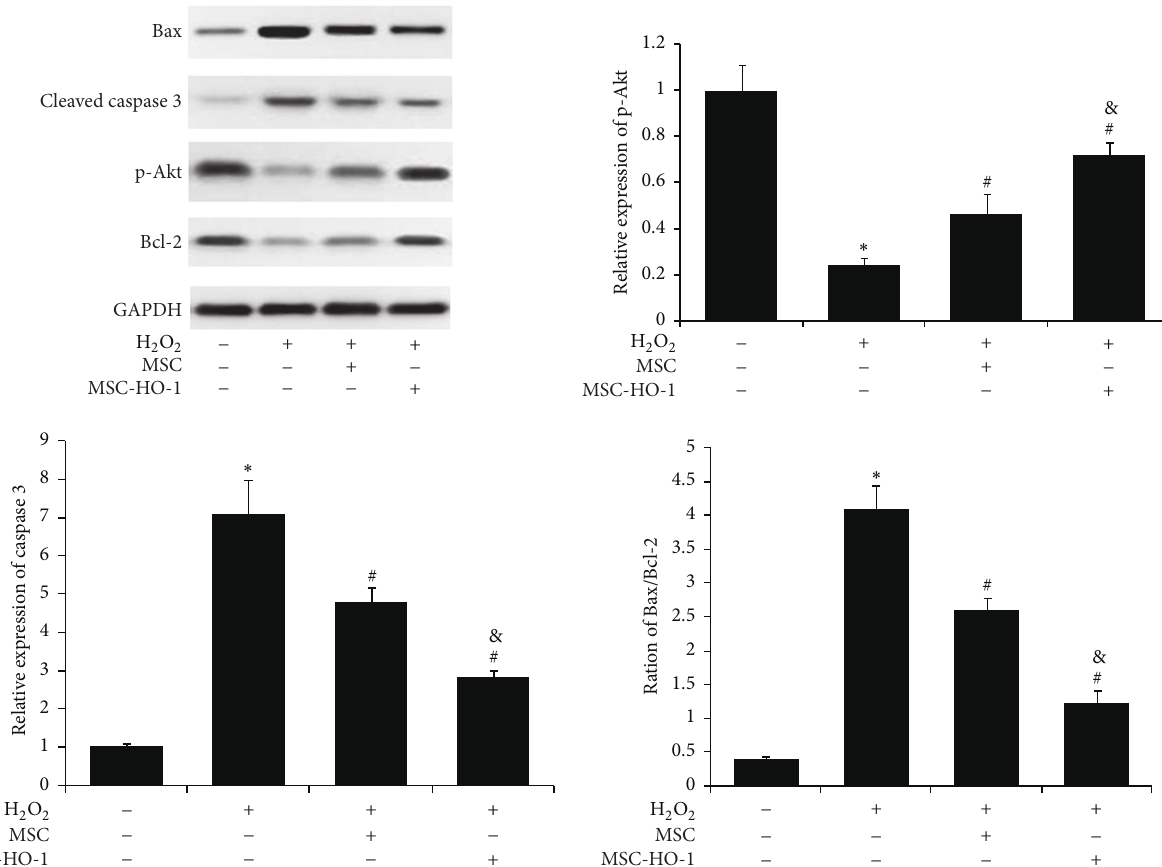
Figure 3: Assessment of apoptosis-related proteins in RGC-5. The levels of apoptotic proteins in H 2 O 2 treated RGC-5 without or with MSC or MSC-HO-1, respectively, were analyzed by western blotting ( 𝑛 = 5 ). ∗ 𝑃 < 0.01 compared with control; # 𝑃 < 0.01 compared with H 2 O 2 group; # 𝑃 < 0.01 compared with H 2 O 2 + MSC